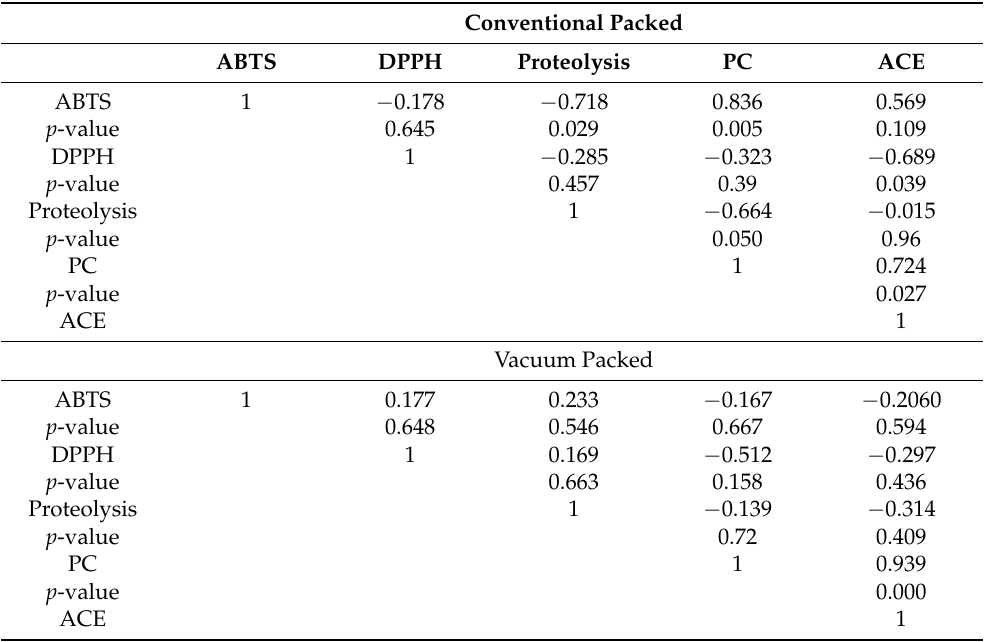
ABTS˙ and DPPH˙ = Antioxidant activity, PC = Peptide concentration, ACE = Angiotensin converting enzyme. p -value = Significance level of the